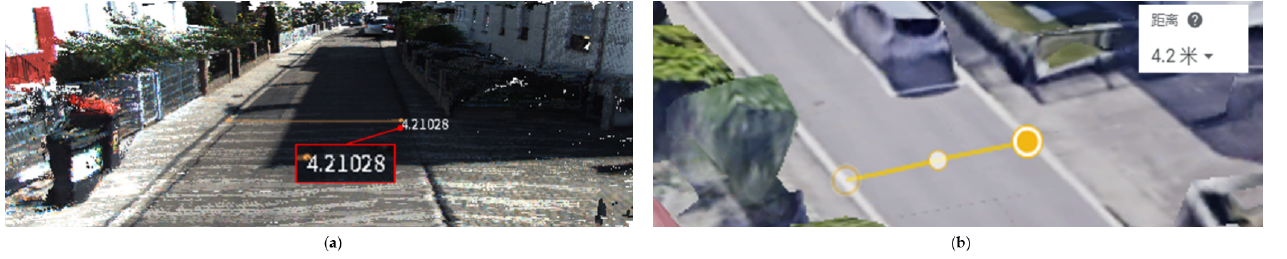
Figure 8. Width comparison between the reconstruction and the real building: ( a ) the length of the building measured using MeshLab is 4.21 m. ( b ) The length of the building measured using GoogleEarth is 4.20 m.